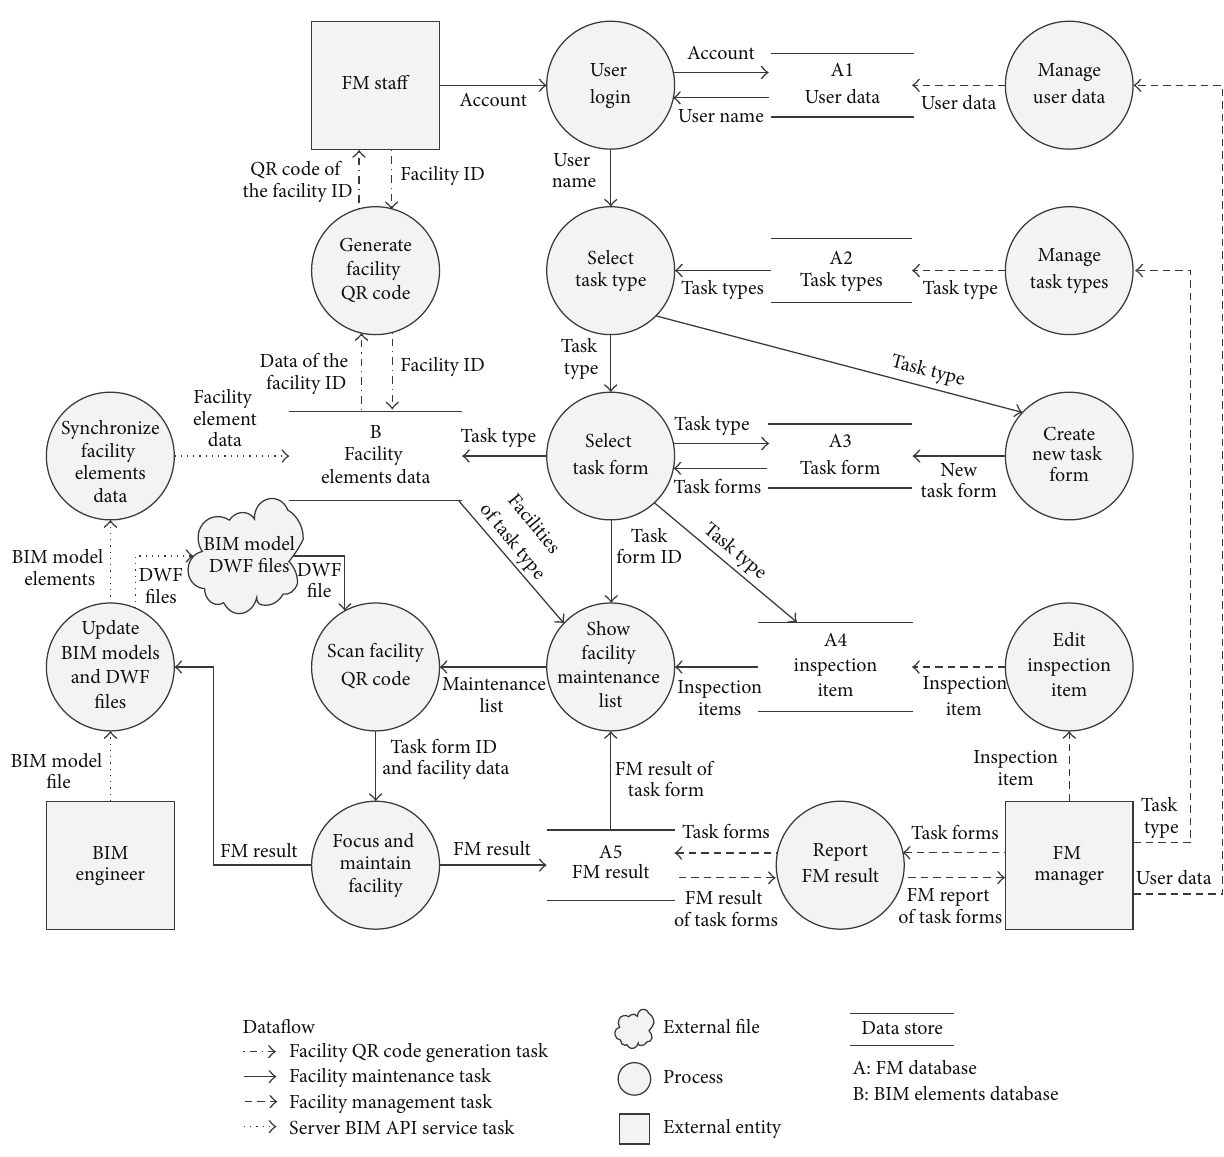
Figure 4: The information flow used in the BIMFM